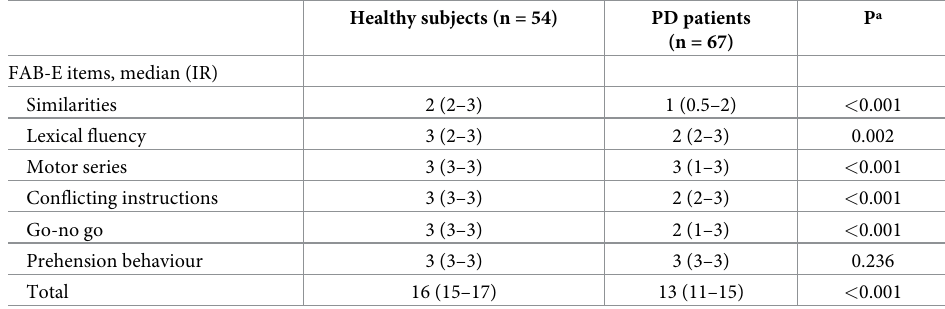
Table 4. Comparison of the performance of the FAB-E scores between control group and Parkinson’s disease patients (n = 121).